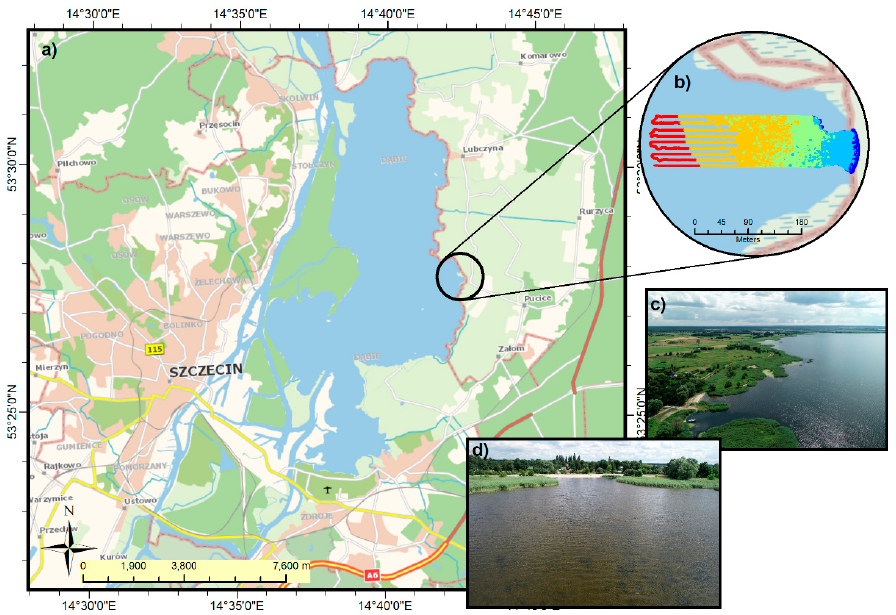
Figure 1. Study area: ( a ) location of D ą bie Lake, ( b ) extent of bathymetric model development, ( c ) top view of the study area, and ( d ) view of the bay with a beach.